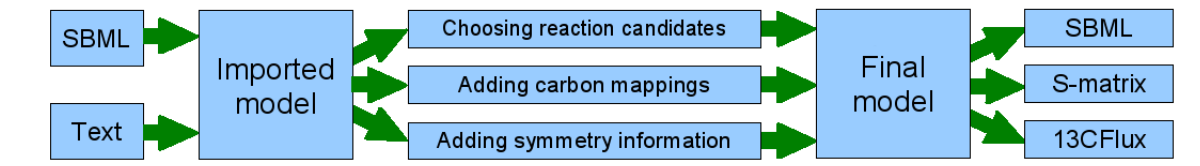
Figure 3: Workflow through the main functionality of